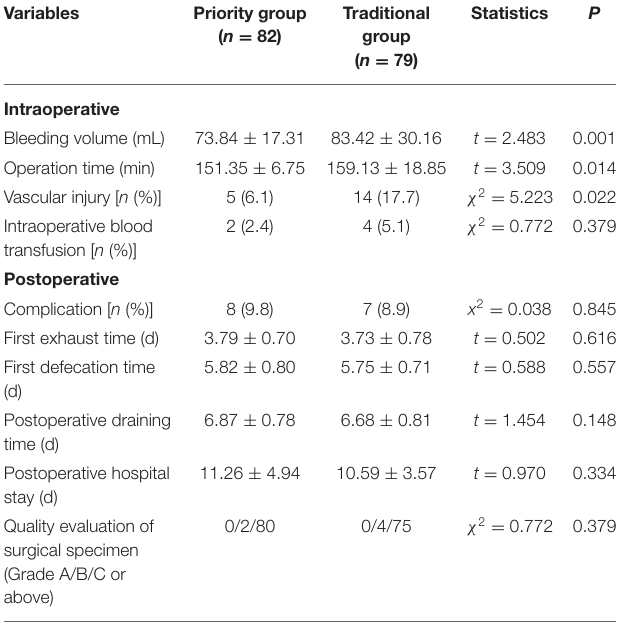
TABLE 2 | Comparison of intraoperative and postoperative